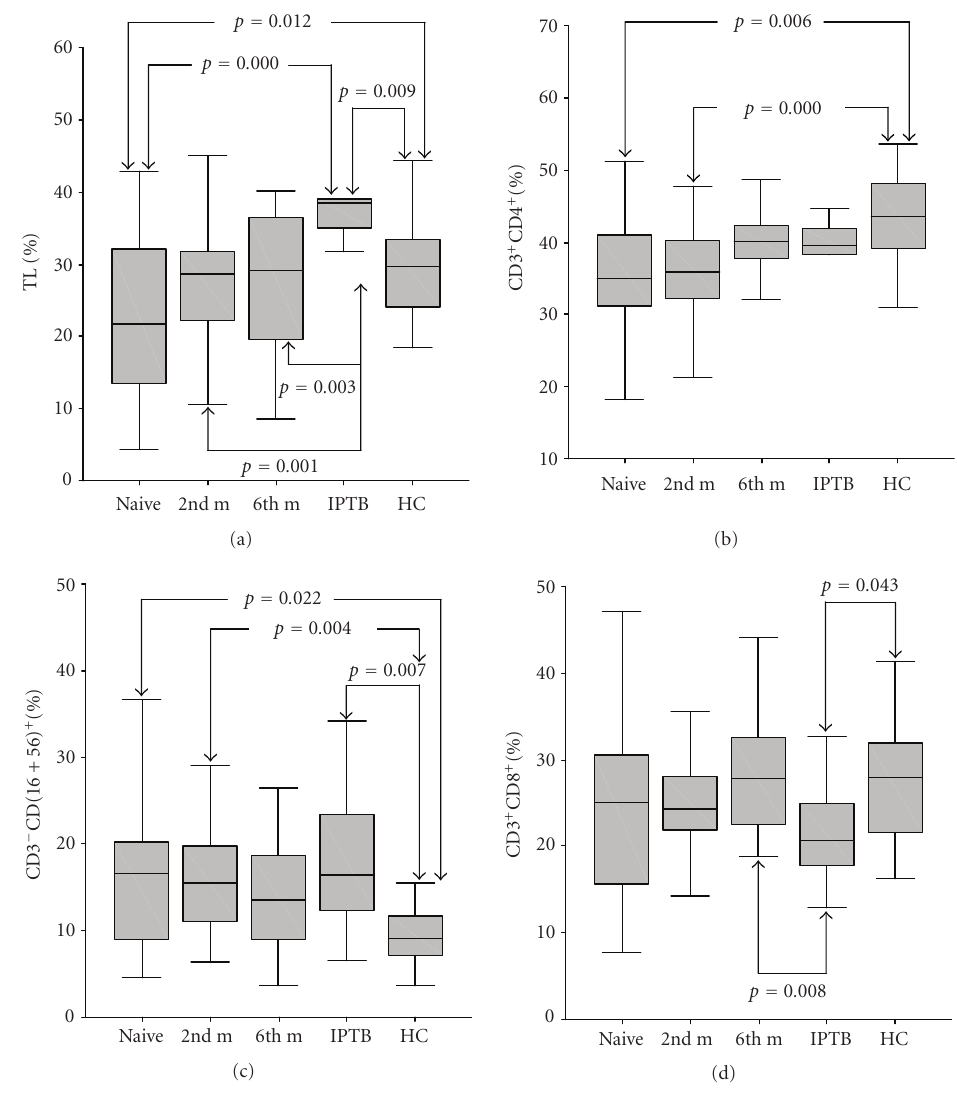
Figure 1: Percentages of total lymphocytes, CD3 + CD4 + , CD3 − CD(16 + 56) + and CD3 + CD8 + lymphocytes in the study groups. (a) Group 1 APTB patients versus HC: p = 0 . 012; Group 1 APTB patients versus IPTB patients: p = 0 . 000; IPTB patients versus HC: p = 0 . 009, Group 2 APTB patients versus IPTB patients: p = 0 . 001; Group 3 APTB patients versus IPTB patients: p = 0 . 003, (b) Group 1 APTB patients versus HC: p = 0 . 006, Group 2 APTB patients versus HCs: p = 0 . 000, (c) Group 1 APTB patients versus HC: p = 0 . 022; IPTB patients versus HC: p = 0 . 007, Group 2 APTB patients versus HCs: p = 0 . 004, (d) IPTB patients versus HC: p = 0 . 043; Group 3 APTB patients versus IPTB patients: p = 0 .